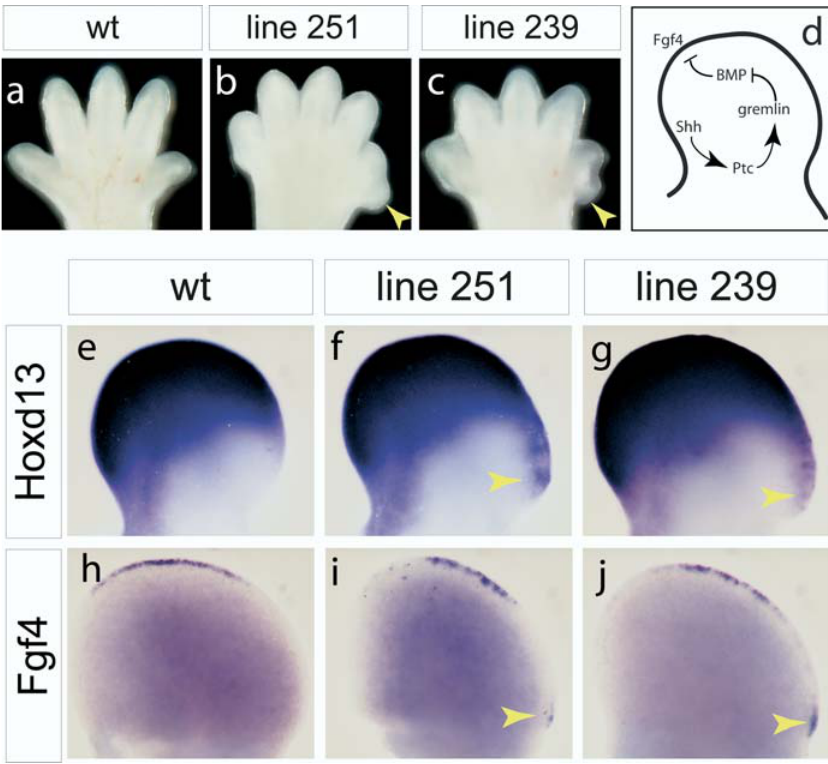
Figure 4. Limb Patterning Defects in Tangential Migration Mutants Anterior is to the right for all limbs. (A–C) Left hindlimbs are shown from E14.5 WT (A), line 251 (B), and line 239 (C). Yellow arrowheads point to extra digits on the anterior (thumb) side of the limb in mutants. Line 275 mutants also have anterior polydactyly. The mutants have a slight developmental delay that causes some differences in appearance of the limb buds at E14.5, when the limbs are growing rapidly. (D) This diagram illustrates components of the Shh/Fgf feedback loop that main- tains Fgf4 expression in the AER. (E–J) In situ hybridization on E11.5 limb buds. Unlike in WT (E), expression of the posterior patterning gene Hoxd13 in left forelimb buds extends ectopically into an anterior domain (yellow arrowheads) in 251 (F) and 239 (G) mutants. Fgf4 expression in left hindlimb buds, re- stricted to the posterior AER in WT (H), has an ectopic expression domain at the far anterior edge of the AER (yellow arrowheads) in 251 (I) and 239 (J)